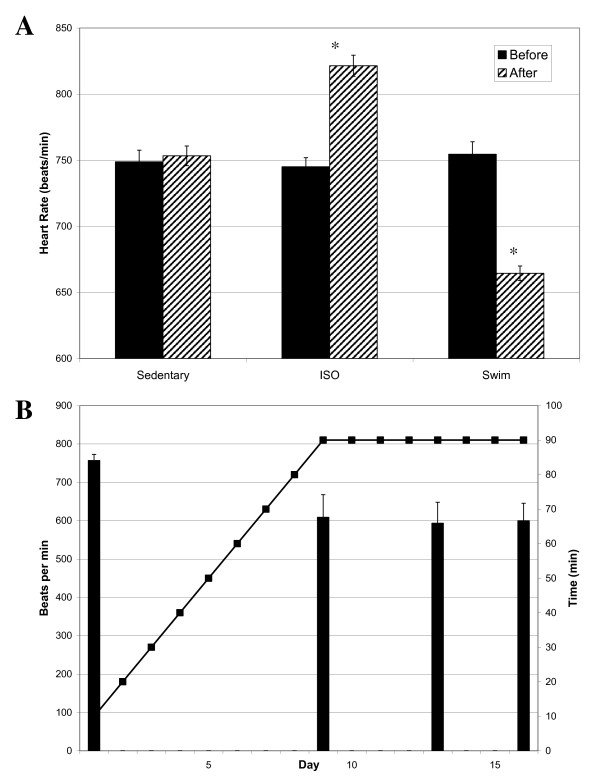
Heart rate is increased under ISO treatment, but reduced under exercise training. A) Comparison of heart rates in sedentary, ISO-treated, and exercised mice. Heart rates were measured before the experiment and on the day of sacrifice (for ISO-treated) or throughout the experiment (for exercised mice). Each heart rate is the average of at least three measurements from rested mice (i.e., swimming mice heart rates were taken in the morning before exercise). Asterisk indicates statistical significance when compared to sedentary control mice, based on one way ANOVA (p value = 0.008, n = 4 and p value = 0.007, n = 6 for ISO and swim mice, respectively). B) Heart rates taken at various time intervals are indicated by bars (mean ± S.E.M), with beats per minute given on the left ordinate. Minutes swam (twice per day) with 5 min/day increases are shown as a line of interconnected points, with minutes per training session displayed on the right ordinate.